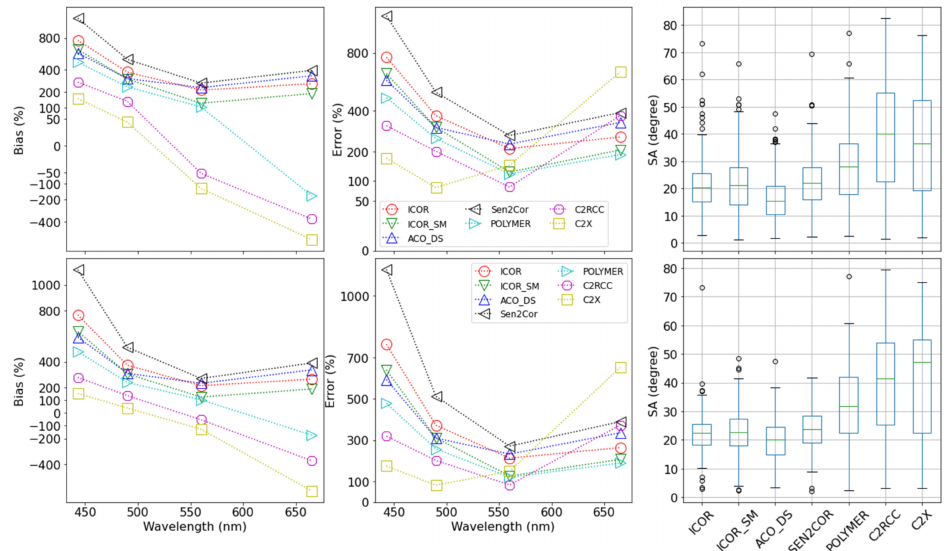
Figure 10. Performance assessment of the processors in terms of median bias (left), errors (middle), and similarity angle (right) for the G-ALL (upper) and G-CIRRUS group (bottom), respectively, for S2/MSI. In the boxplots, the median values are shown as the green lines, and the circles represent the